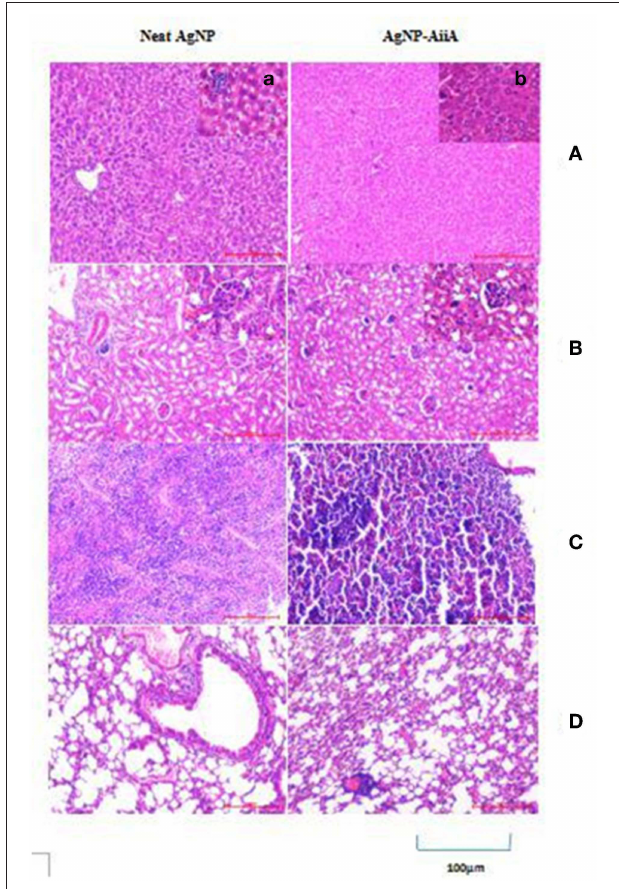
FIGURE 14 | Histological and pathological observations for mice intravenously injected with 14.4 µ g neat AgNPs and AgNP-AiiA complex. Each mouse was sacrificed after 48h of injection and tissue samples of liver, kidney, spleen and lung were collected. (A) The representative image of liver. The scale bar in the image represents 100 µ m. (a) Enlarged view of Kupffer cells. (B) Morphological observation of kidney. (b) Enlarged view of glomerulus. (C) Spleen showing red pulp and white pulp. (D) Lung showing bronchiole and